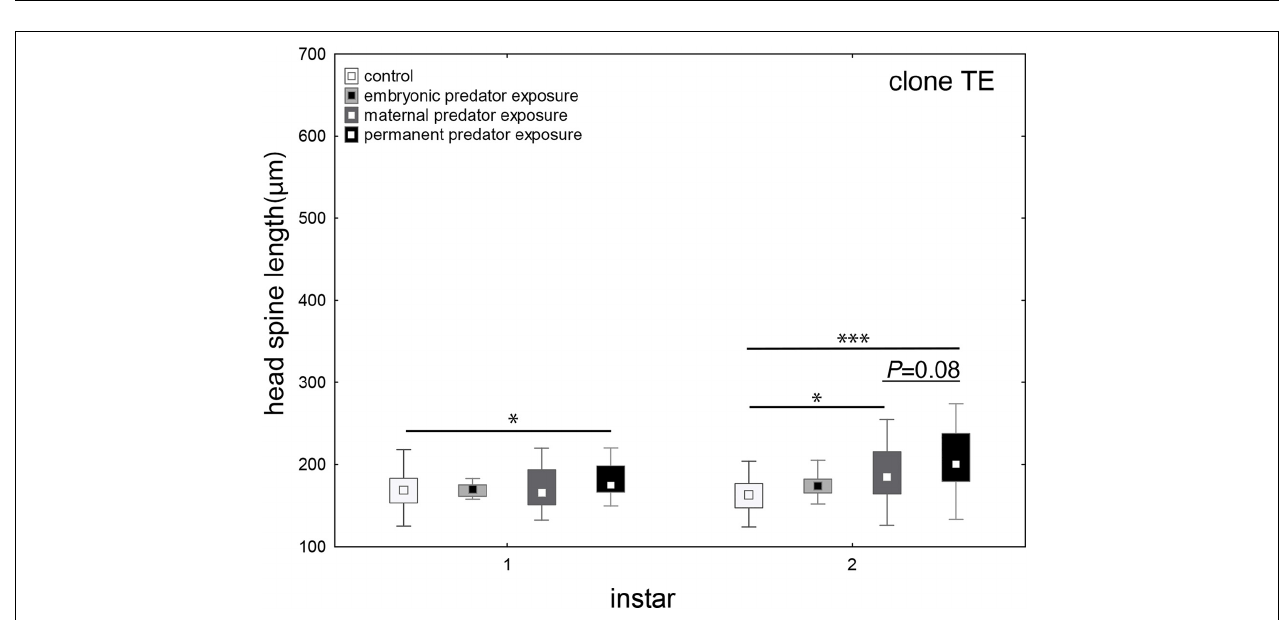
FIGURE 3 | Absolute head spine growth across generations. The proportional increase in head spine length from the 1st to the 3rd juvenile instar increases across generations when D. lumholtzi is permanently exposed to kairomones. F0 generation: n = 29, F1 generation: n = 37, F2 generation: n = 35. F ( 2 , 98 ) = 11.008, P ≤ 0.001. Bonferroni post hoc comparison. Displayed are medians (square), midspread 50% (box) and the 25th percentile (lower whisker); 75th percentile (upper whisker), with outliers (circles). * P ≤ 0.05; ** P ≤ 0.01; *** P ≤ 0.001. Bonferroni post hoc analysis in Supplementary Tables 7 , 8 .